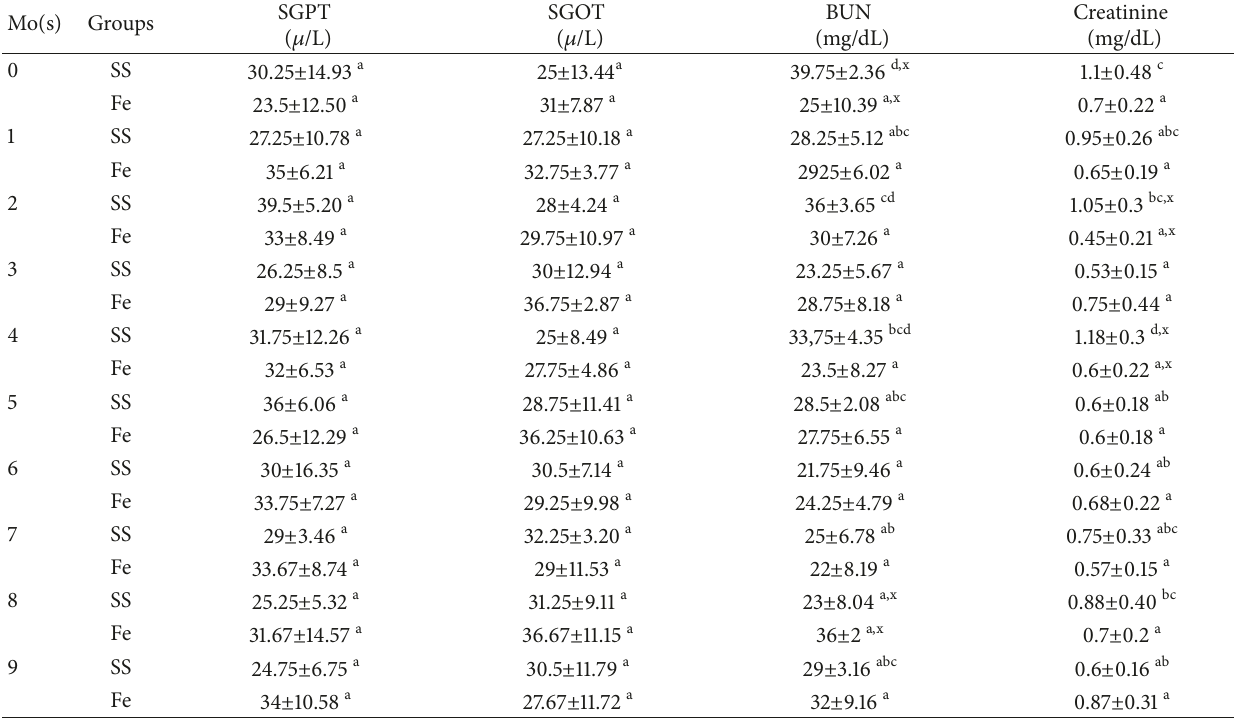
Table 3: Blood chemistry results of iron-based implant in tibia shaft fracture in month 0 until 9 after implantation in sheep. Mo(s)